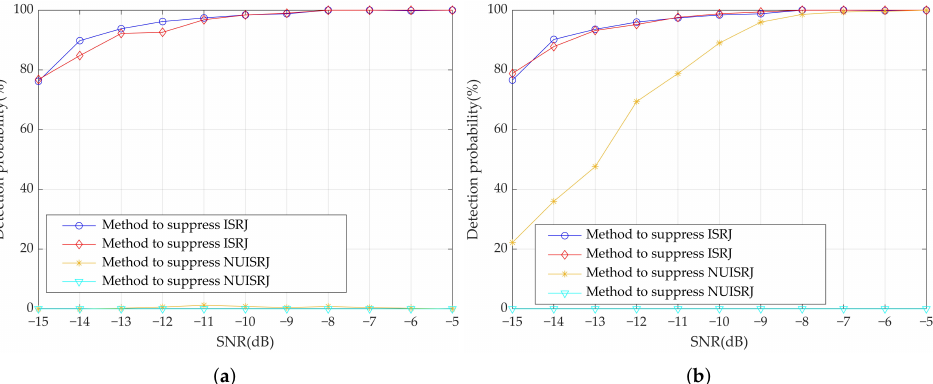
Figure 11. Under different JSRs, the detection probability after jamming suppression changes with SNR: ( a ) JSR = 10 dB, ( b ) JSR = 20 dB. (blue and yellow) [21], (red and cyan)